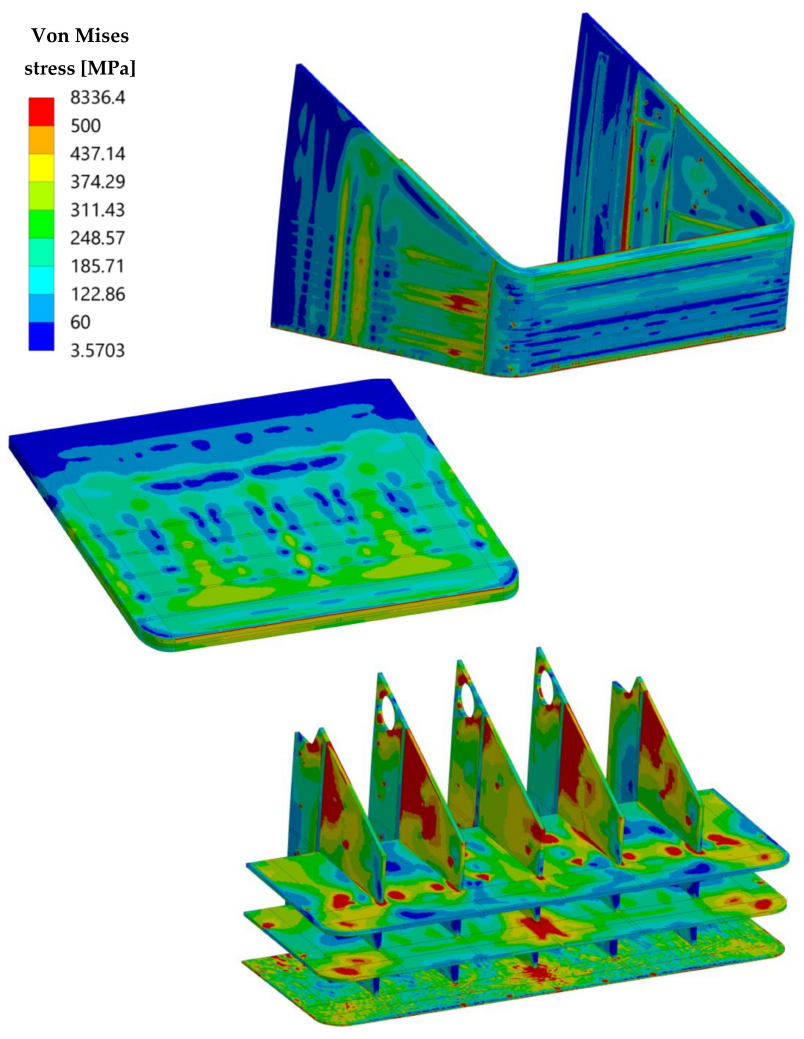
Figure 12. OP von Mises equivalent stress fields within the “TC region-mod+” geometric